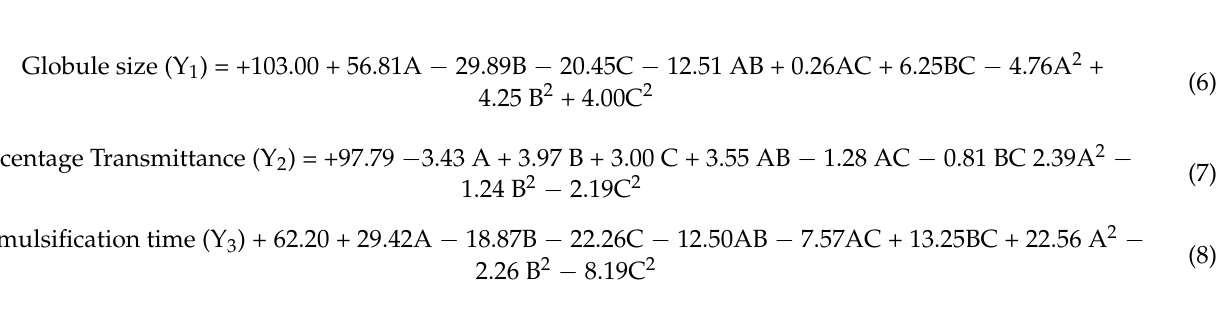
Table 2. Formulation composition for various composition obtained from Box-Behnken design with actual and predicted values of